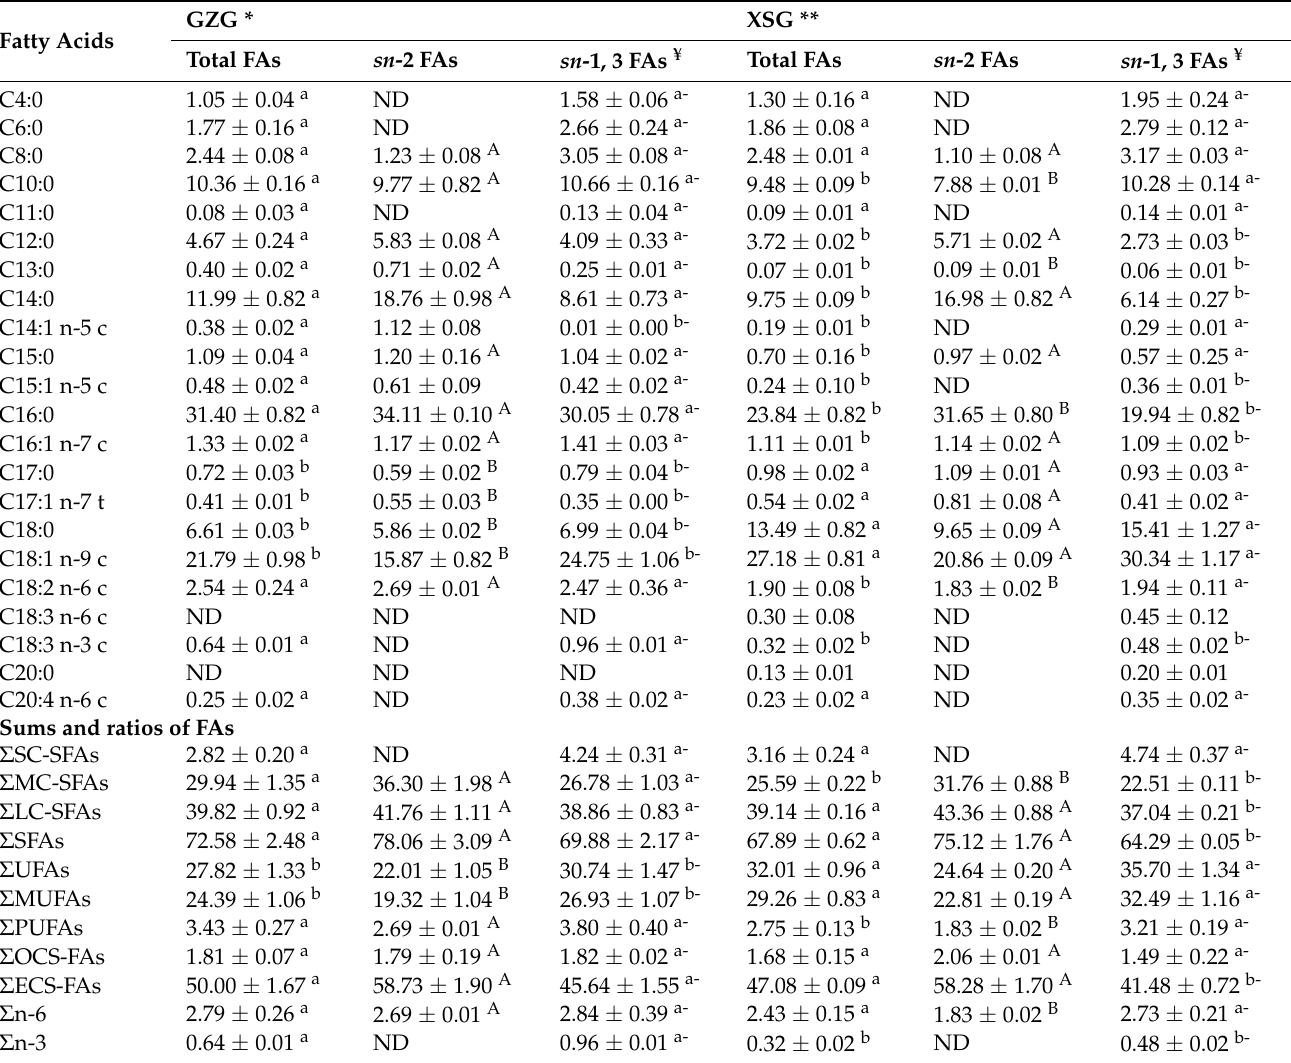
Table 1. Fatty acid composition (peak area %) and the positional distribution ( sn -2 and sn -1, 3) of fatty acid in goat milk fat samples detected using